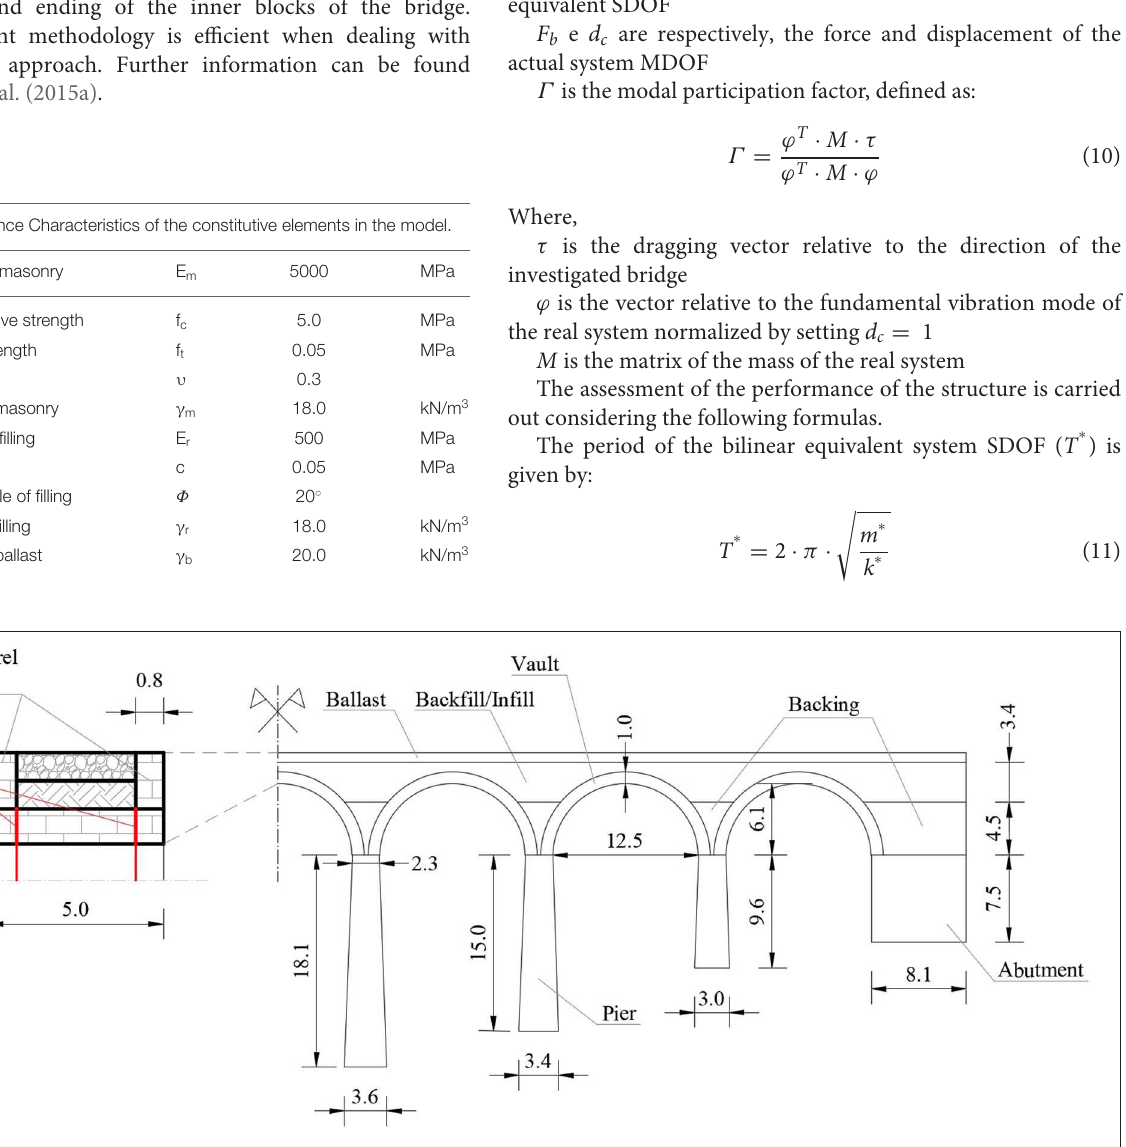
FIGURE 4 | Geometrical properties of the case study.